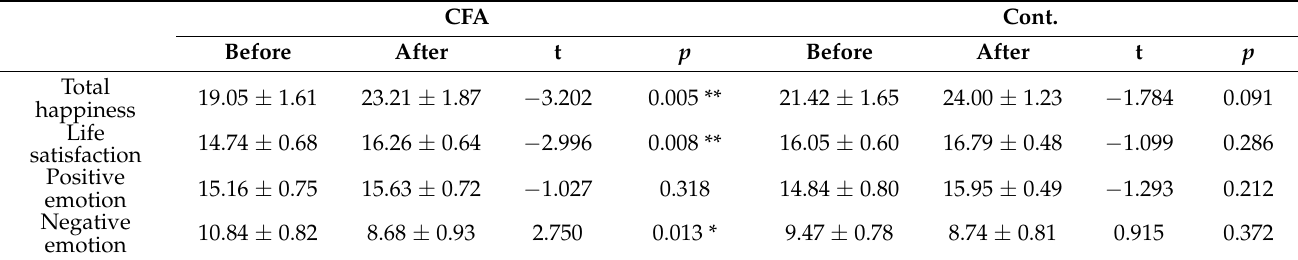
Table 4. The results of paired t -test analyses of Concise Measure of Subjective Wellbeing (COMOSWB) scores. CFA Cont. Before After t p Before After t p Total